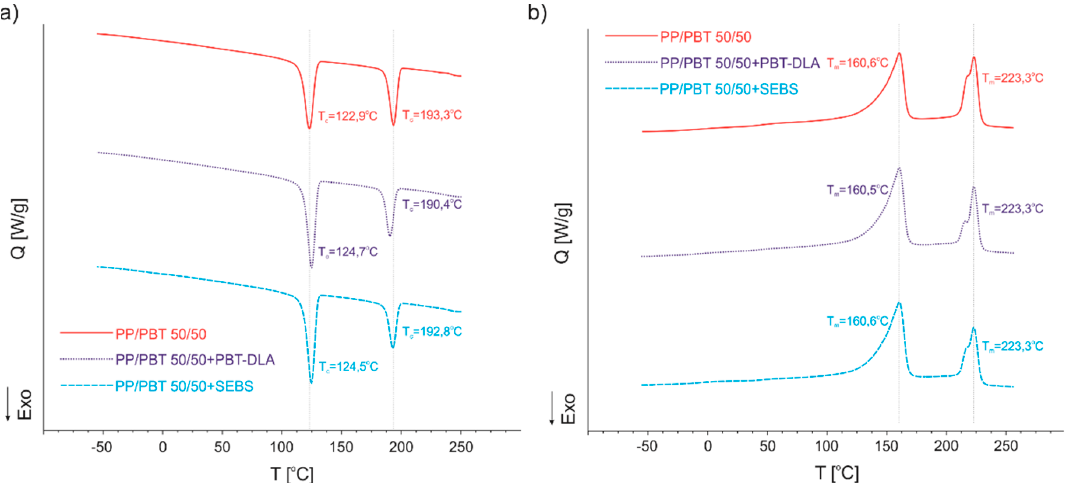
Figure 11. DSC thermograms of 50 / 50 PP / PBT blends with and without compatibilizers. ( a ) Comparison of crystallization behavior; ( b ) comparison of melting